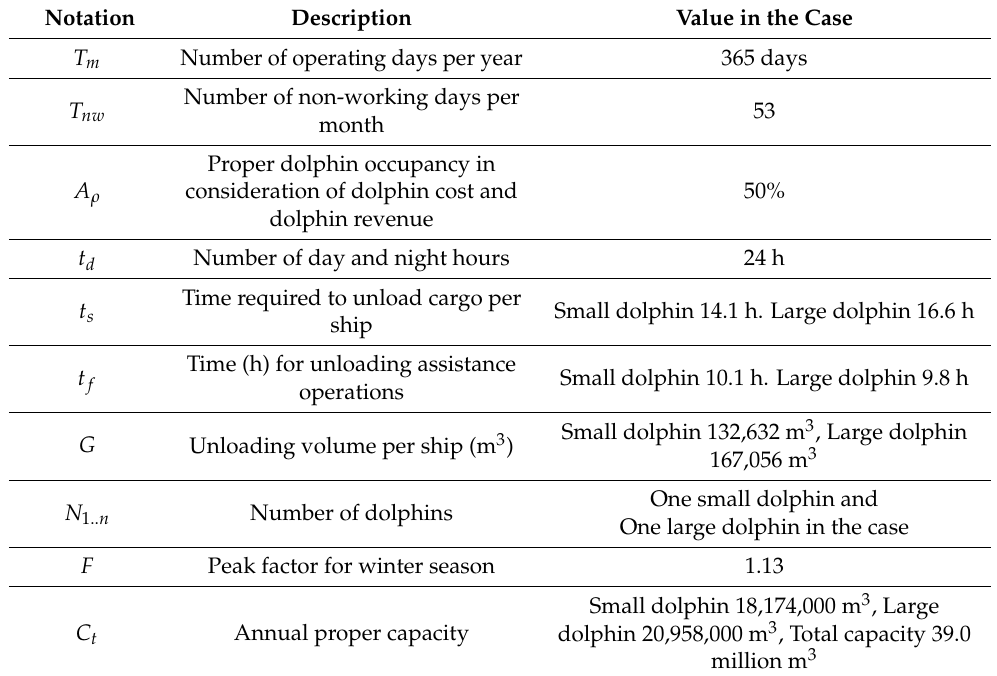
Table 1. Dolphin occupancy and ship waiting